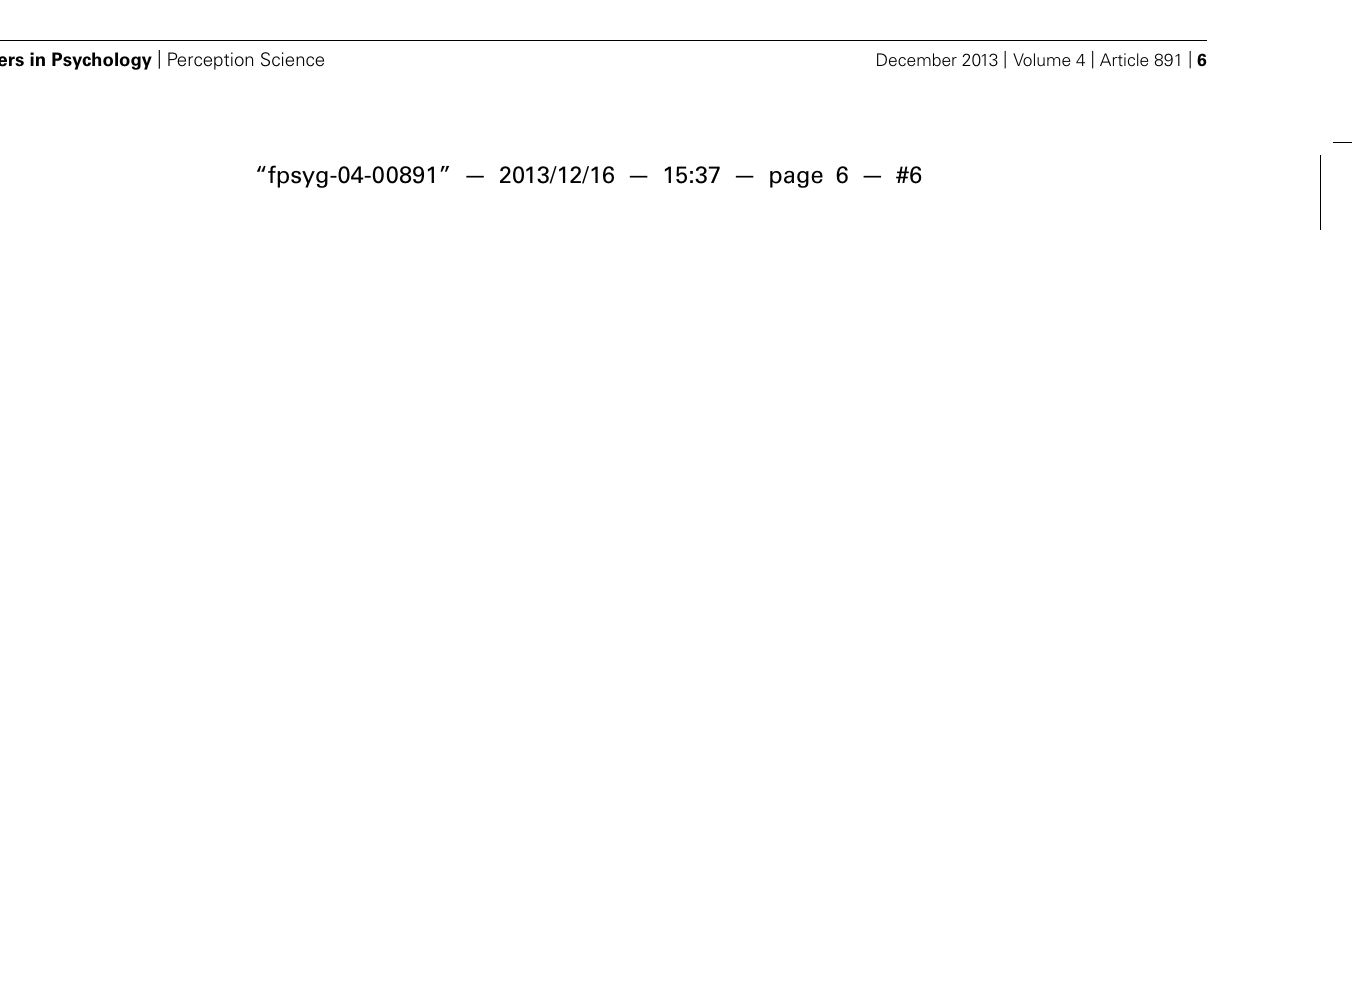
citations/uses during that year. Edge links between nodes represent co-occurrence (in the case of terms) and co-citation (in the case of articles), with the color representing the first year in which the connection was